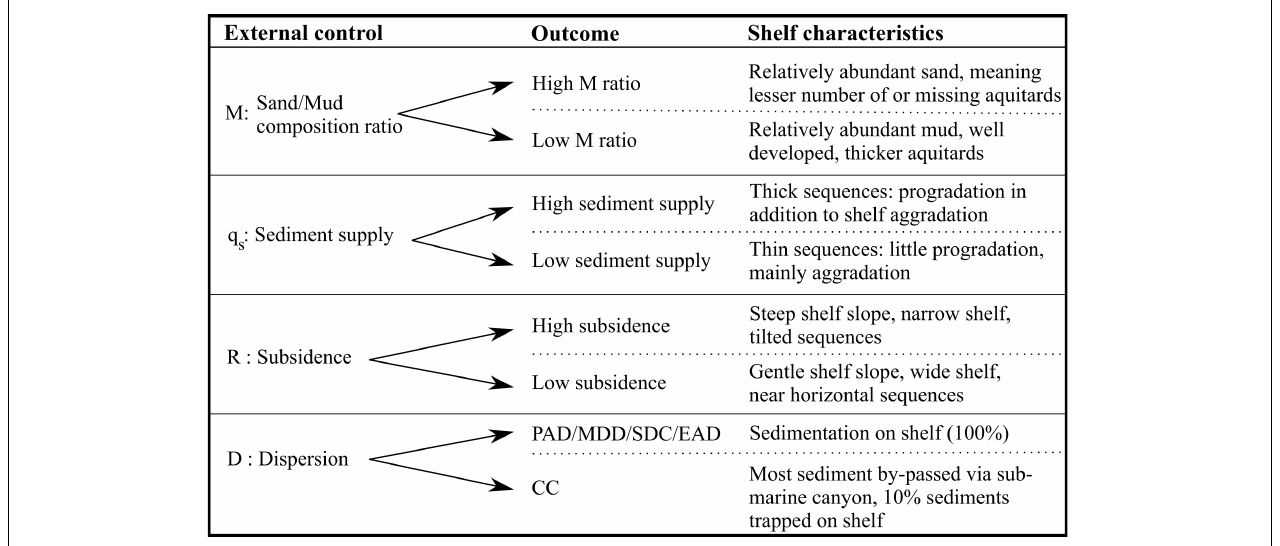
FIGURE 1 | Hydrogeological summary variables for COSCAT/MARCAT shelf regions. The sediment dispersion modifier D is 1 for all but one of Walsh and Nittrouer (2009)’s shelf categories (EAD: estuarine accumulation dominated; PAD: proximal accumulation dominated; SDC: subaqueous delta clinoforms; MDD: marine dispersal dominated). It is set to 0.1 for those shelved captured by major submarine canyon